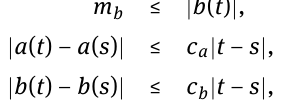
Figure 2: Student distribution with ν = 2 df. (a): Simulated data ( + ) and conditional quantiles q (3/4 | ·) (magenta), q (1/2 | ·) (green) and q (1/4 | ·) (blue). (b): Location function a (·) (black) and mean estimate ¯ˆ a ¯ˆ mean estimate b n (·) (red). (d): Conditional tail-index γ (black), estimates ˆ γ n , i , i = 1, . . . , N (blue) and mean estimate ¯ˆ γ n (red) as functions of k 1, . . . , 300 } n ∈ {